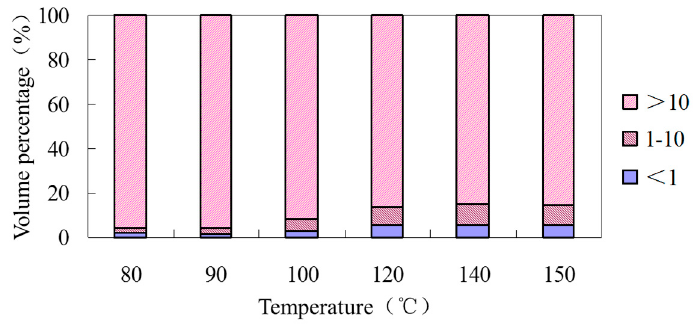
Figure 7. Void distribution of mixtures compacted at different temperatures.